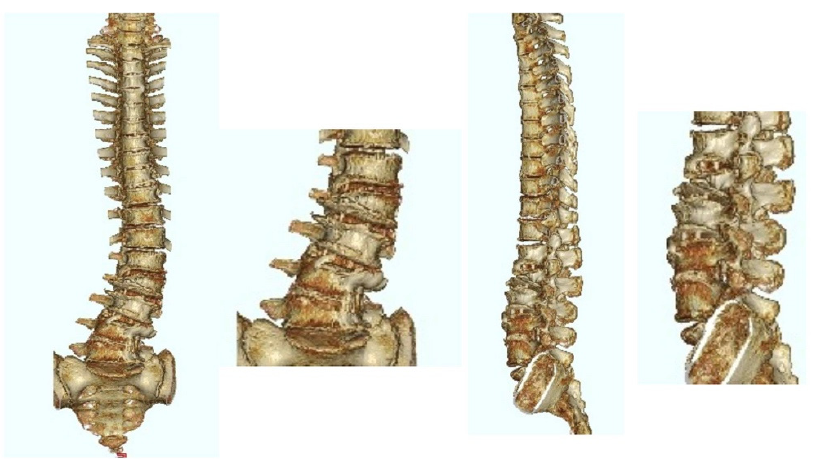
Figure 6. Postoperative 3D CT image of the same patient as in Figure 5. The patient underwent LLIF at L1/2, L2/3, and L3/4 using PEEK cages.